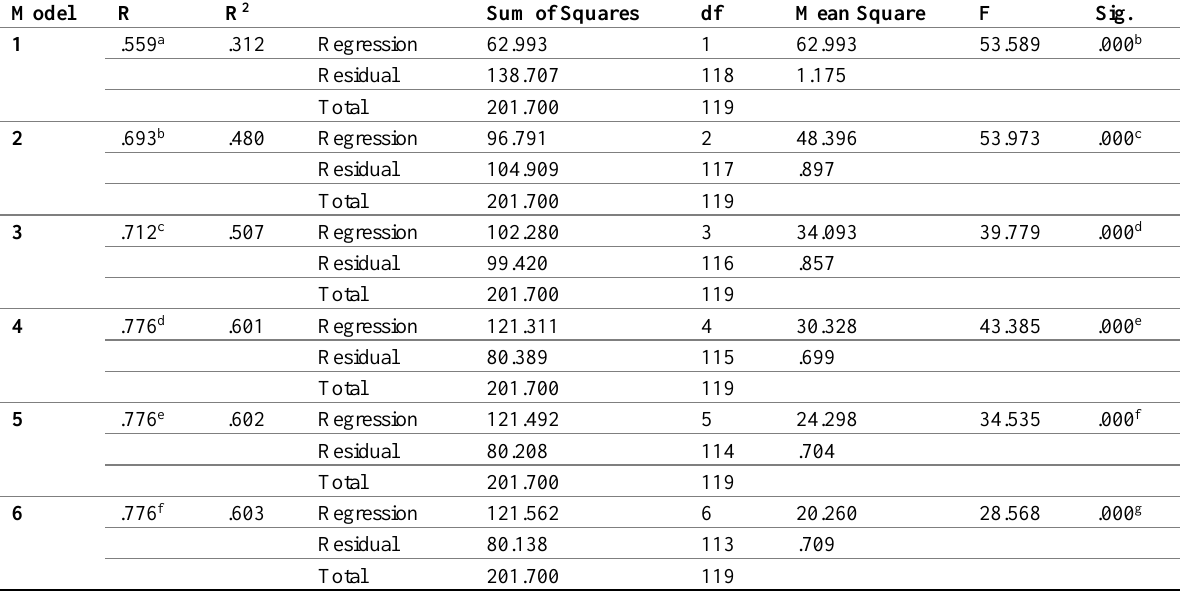
Table 3: Hierarchical multiple regression analysis of the influence of demographic variables on work-stimulated stress Model R R 2 Sum of Squares df Mean Square F Sig. 1 .559 a .312 Regression